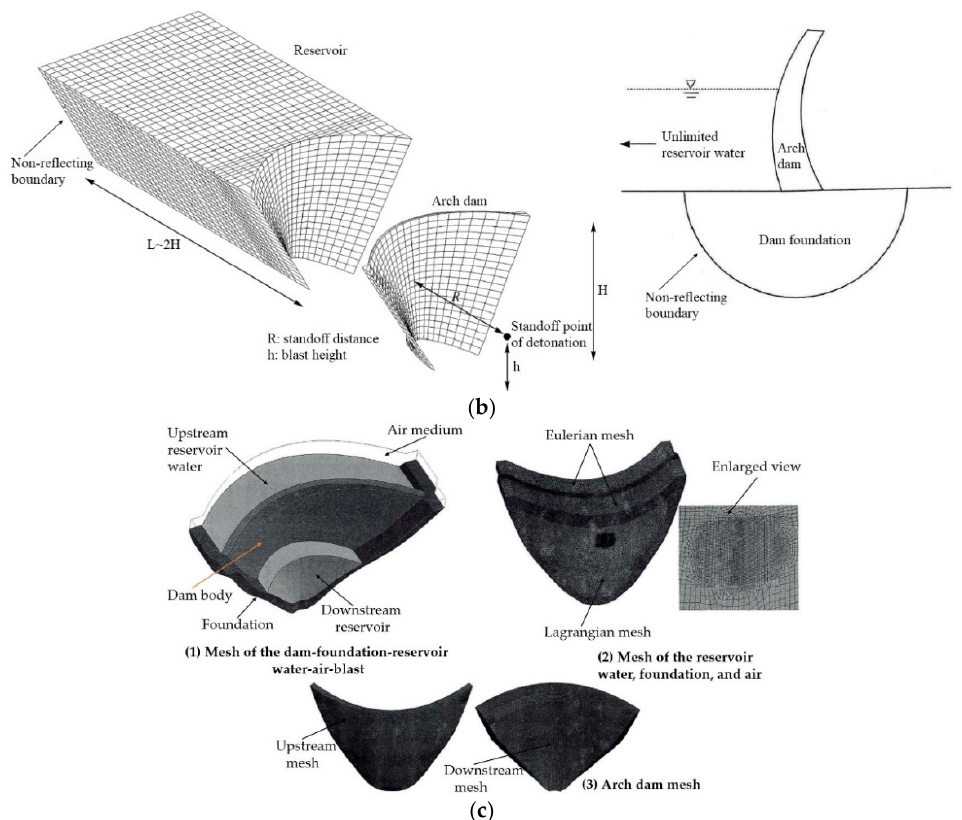
Figure 1. ( a ) Contour and size of the optimized arch dam model, ( b ) schematic diagram of the calculation domain, and ( c ) meshing of the model.